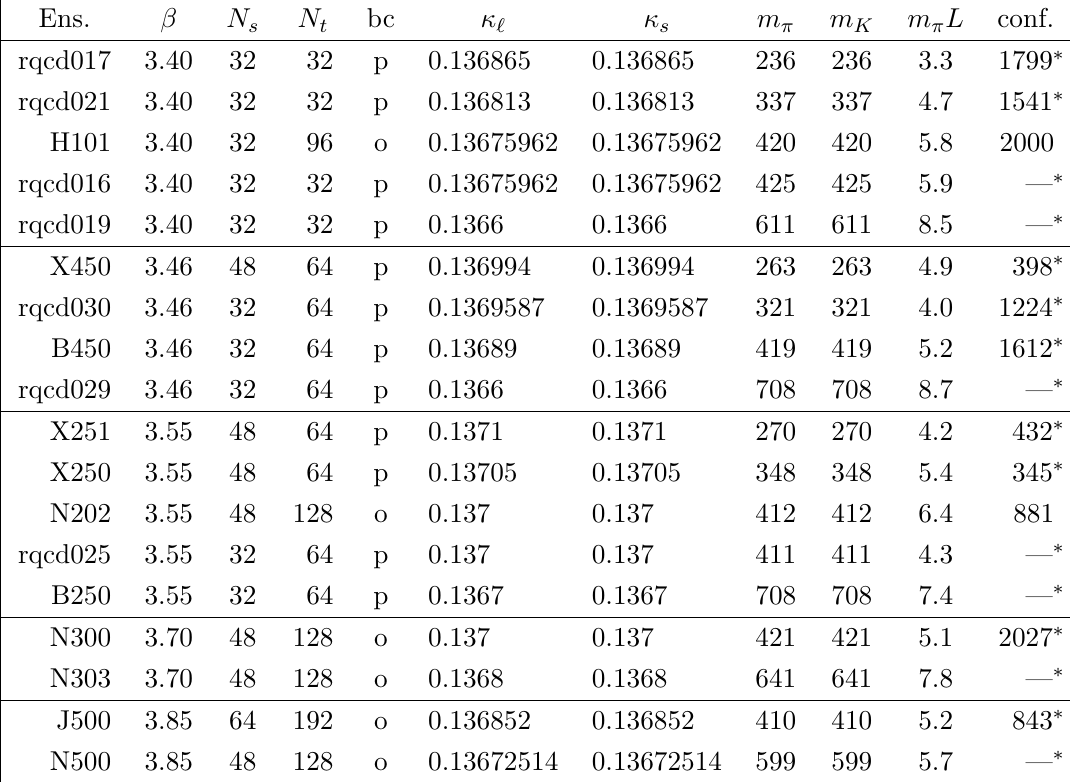
Table 8 . The same as table 6, but for the m ‘ = m s trajectory. Renormalization factors are deter- mined from the lattices marked by an asterisk. The number of con(cid:12)gurations refers to those used for the measurement of the second moments, i.e., ensembles with | (cid:3) are only used for renormalization.